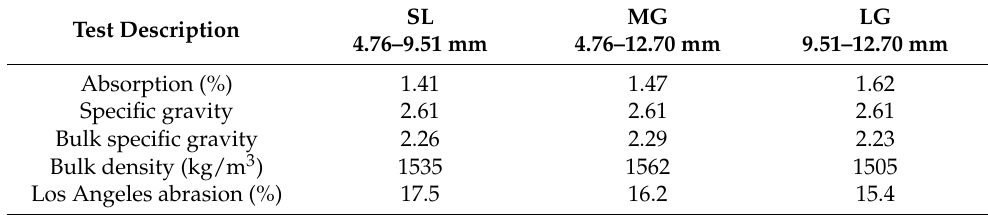
Table 2. Summary of gravel aggregate properties.